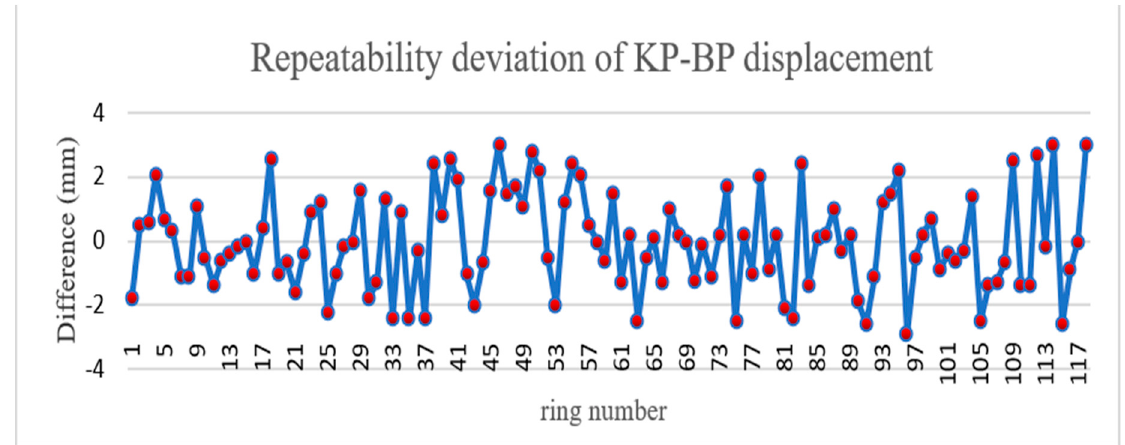
Figure 14. Repeatability deviation of KP-BP displacement.